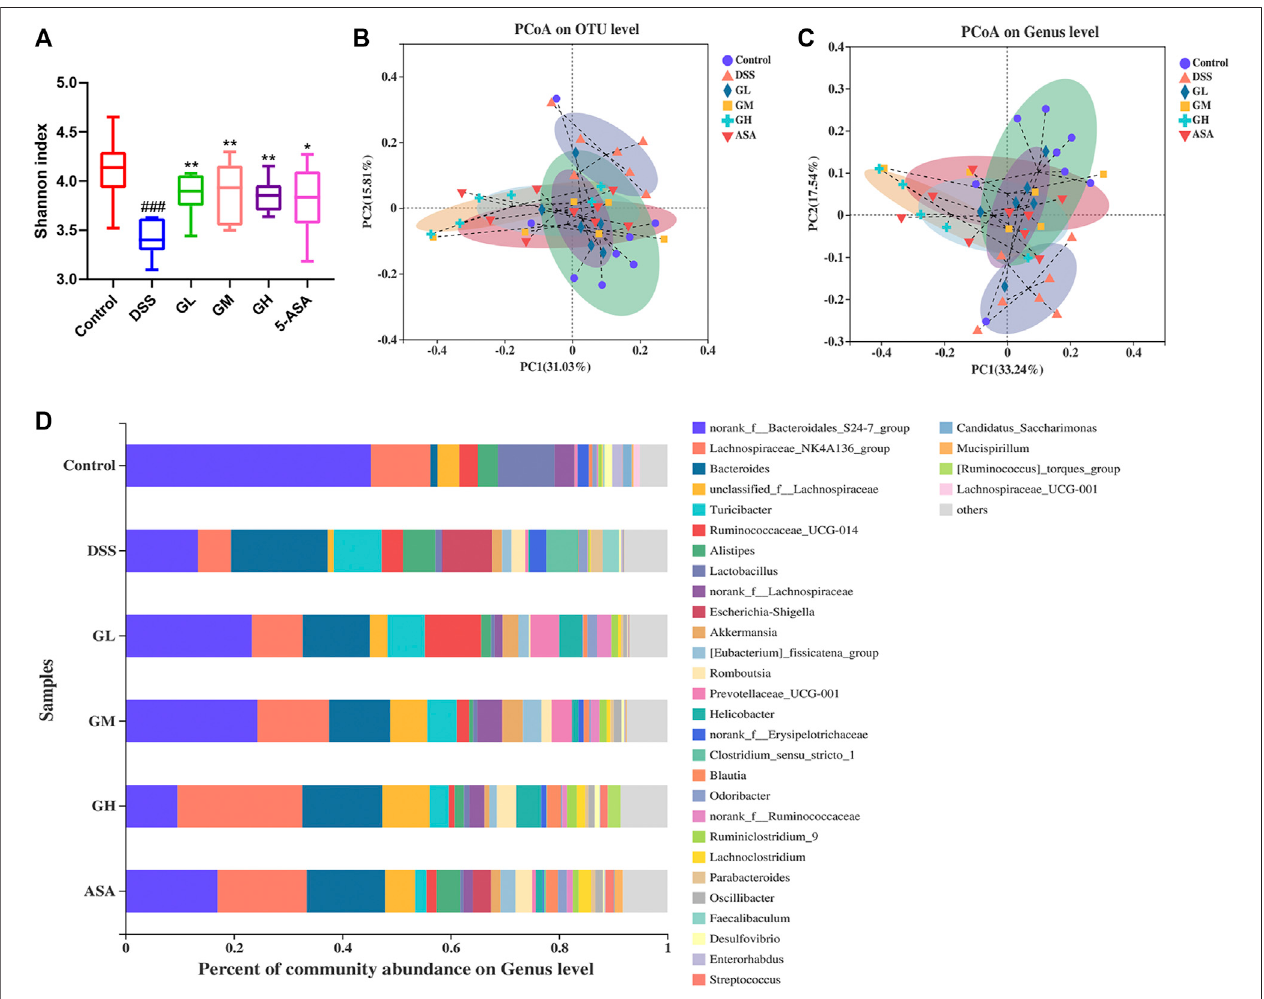
FIGURE4| MGQDtreatmentsigni fi cantlyalteredthegutmicrobiotaincoliticmice. (A) AlphadiversitywasestimatedbyusingShannonindex. (B) and (C) Principal coordinate analysis (PCoA) based on Weighted-Unifrac distances among six groups at the OTU level and the genus level. Each symbol represents an individual mouse. (D) The bar plot of community composition on the Genus level. ### p < 0.001, vs control group; * p < 0.05, ** p < 0.001, vs DSS group.